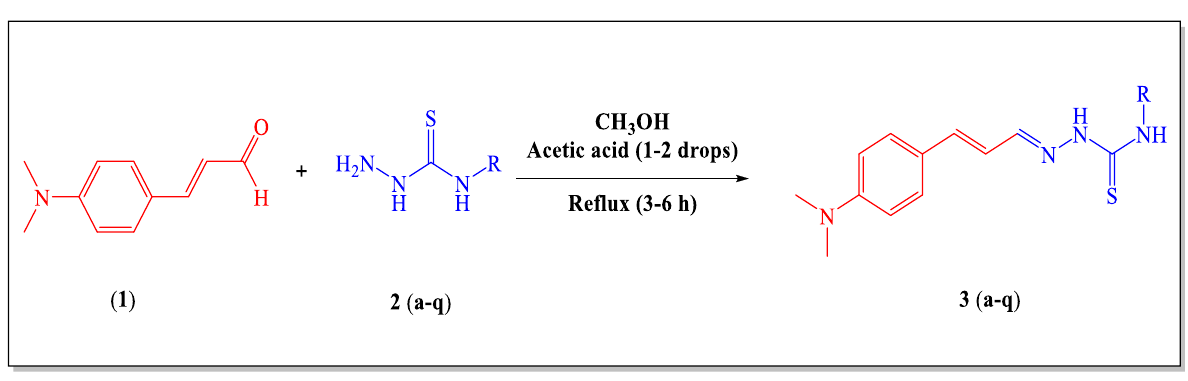
Scheme 1. The synthetic route of compounds